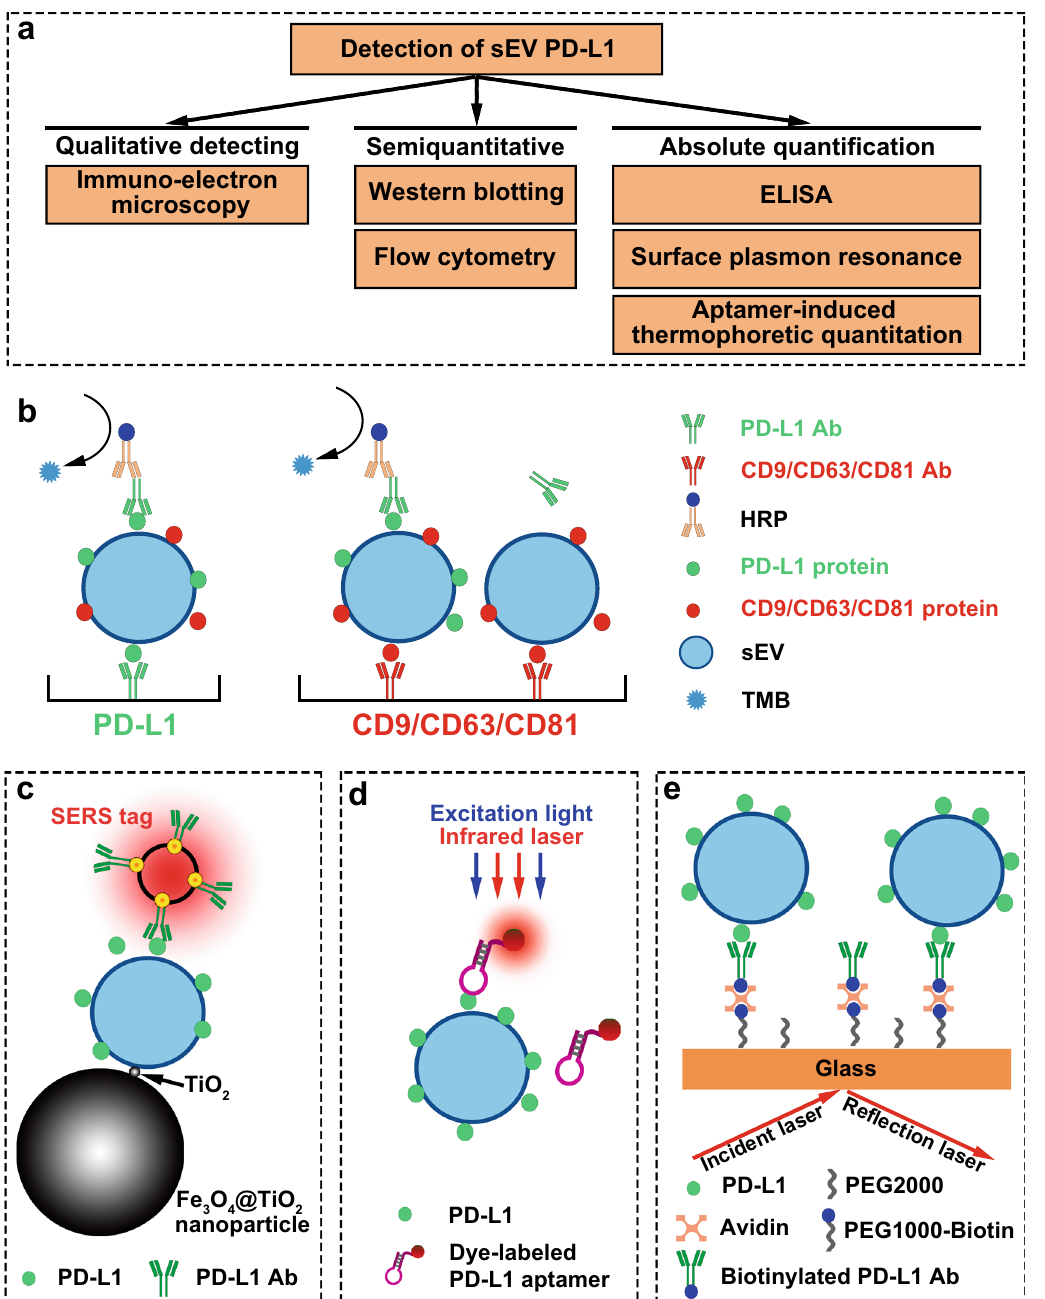
Fig. 3 The detection strategies of sEV PD-L1. a The detection methods of sEV PD-L1 were divided into three categories based on the qualitative detection and quantitative determination. b Schematic of ELISA to measure PD-L1 levels on the surface of sEVs. c PD-L1 level were quanti fi ed by anti-PD-L1 antibody-modi fi ed Au@Ag@MBA surface-enhanced Raman scattering (SERS) tags. d An ef fi cient and sensitive quantitation method for circulating sEV PD-L1 using aptamer-induced thermophoretic quantitation. e Surface plasmon resonance (SPR) biosensor to detect the sEV